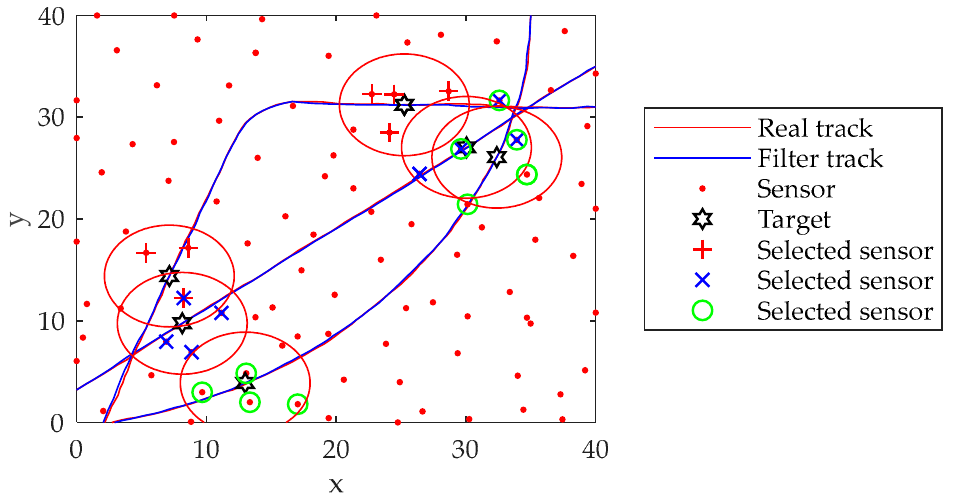
Figure 8. The 25 s and 80 s sensor scheme selection.